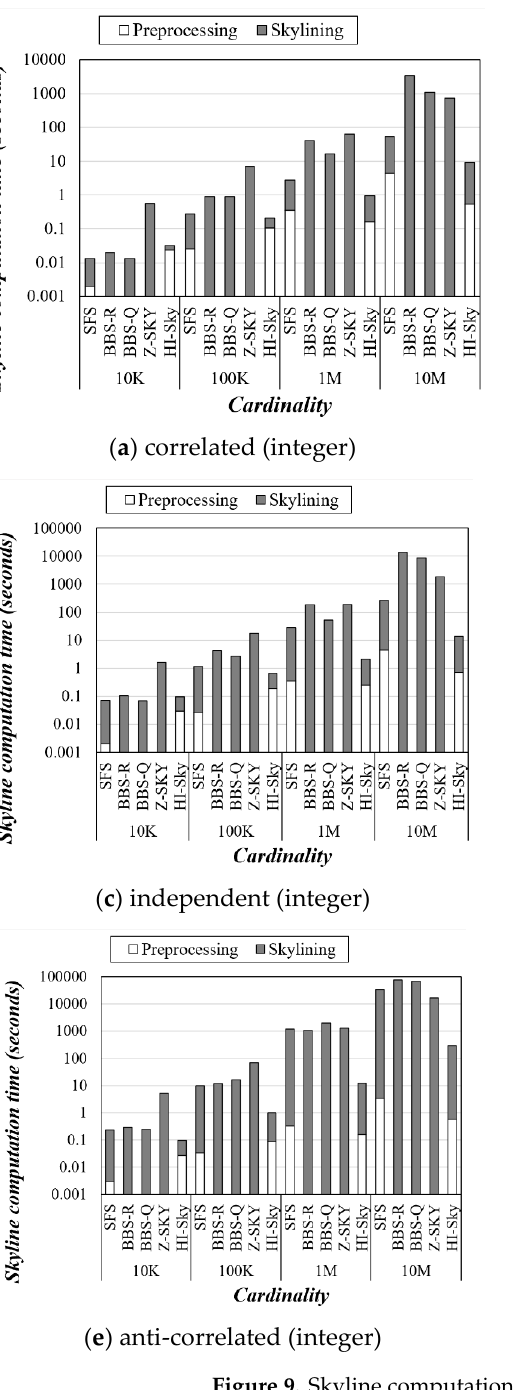
Figure 9. Skyline computation time according to cardinality.